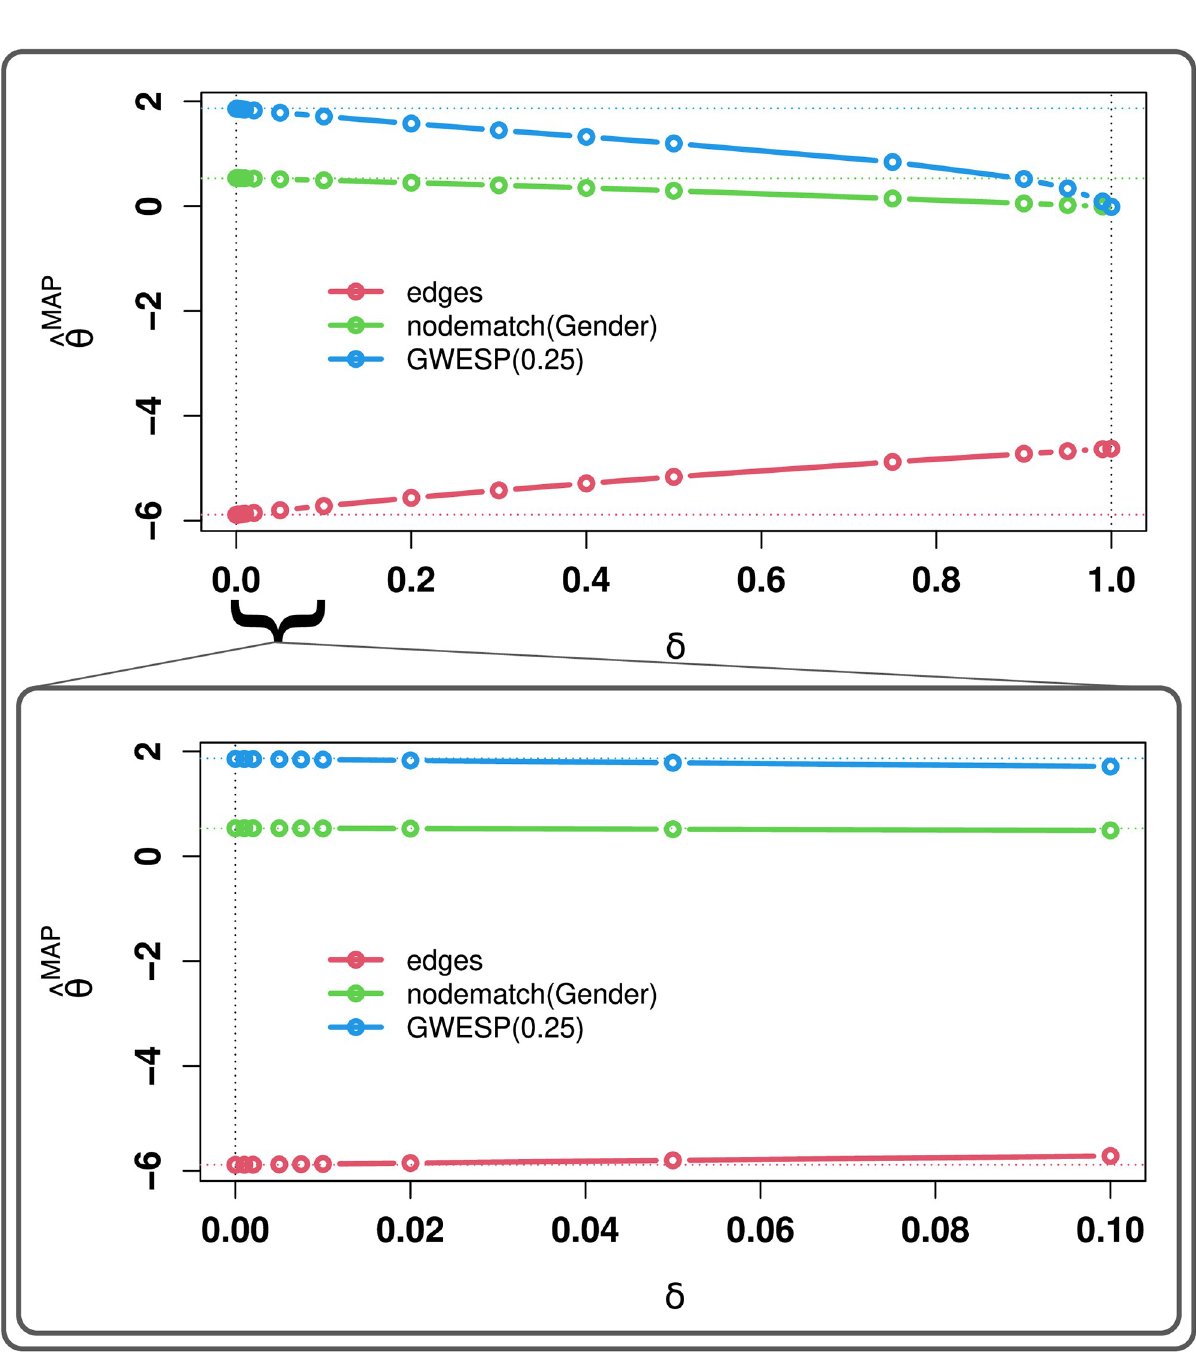
Fig 1. Average MAP estimates for Y � M , by δ . Solutions interpolate between the natural parameters corresponding to the prior ( δ = 1) and the MLE ( δ = 0); shrinkage is nearly linear in δ near the non-informative limit (bottom panel). Dotted horizontal lines show data generating parameters. approximation) to the coefficients of true model M , which is θ = ( − 5.885, 0.532, 1.867); at the 0 other extreme, we have the natural parameter equivalent of the location of the conjugate prior ( − 4.63, 0, 0). Table 3 shows the estimated bias and frequentist coverage probability for our sim- ulation sample, as a function of δ . As can be seen, bias is minimal until δ � 0.02, becoming